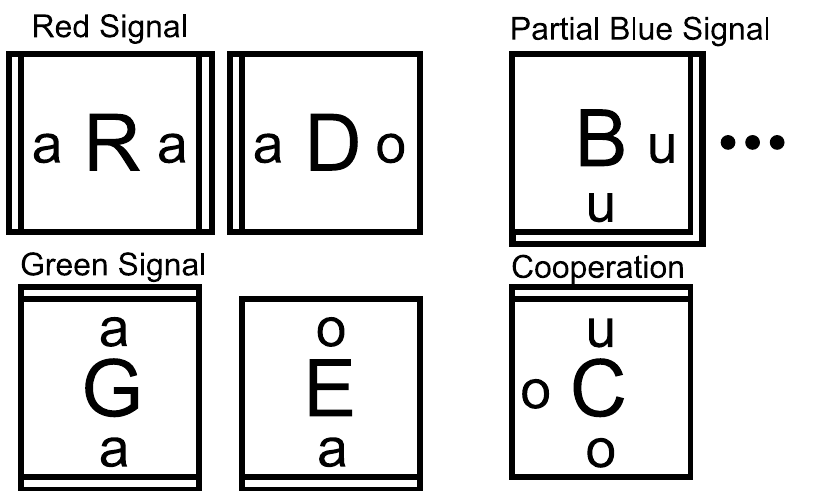
Fig 3. A tile set designed for a temperature 2 assembly system that uses cooperation to simultaneously detect nondeterministic input signals, red (R) and green (G), and from the designed point of cooperation output a deterministic signal to the blue (B) site. For cooperative assembly, double edges indicate strength 2 glues, and single edges strength 1. When the system is run in noncooperative mode, all glues are strength 1. R and G propagate from the inputs r and g by a series of R and G tiles. The D and E tiles are placed nondeterministically at some point along the signal to enable attachment of the cooperation tile C. At the point of cooperation, the O tile binds cooperatively, and then, grows the deterministic blue signal by a series of B tiles (only the first one is shown here.) The number of tiles in the blue signal is constrained by the size of the assembly space L .